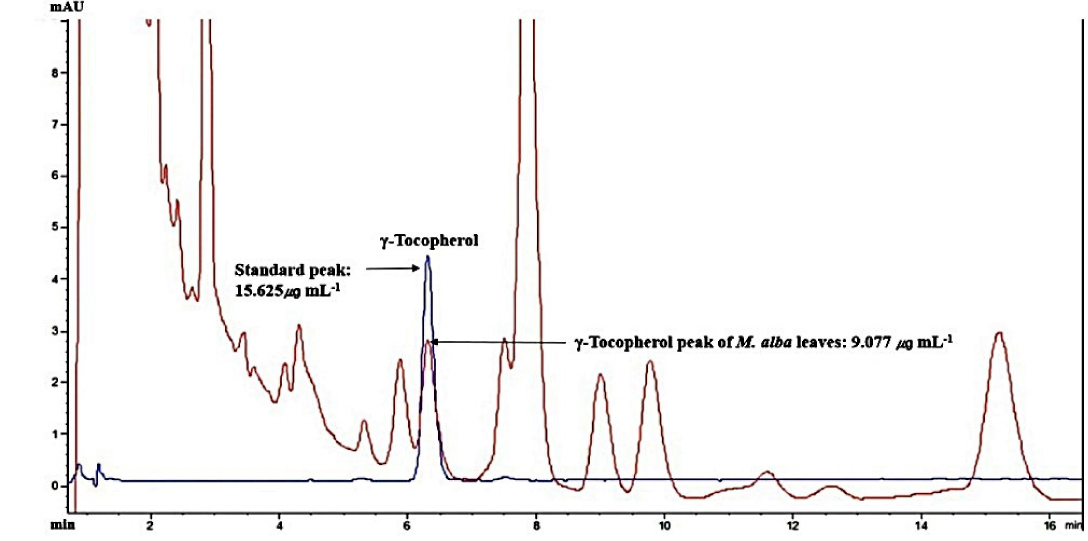
Figure 9. Overlapping HPLC chromatograms obtained by standard γ -Tocopherol (blue curve) and γ -Tocopherol (red curve) in M. alba L. leaves MeOH extraction, wavelength: 290